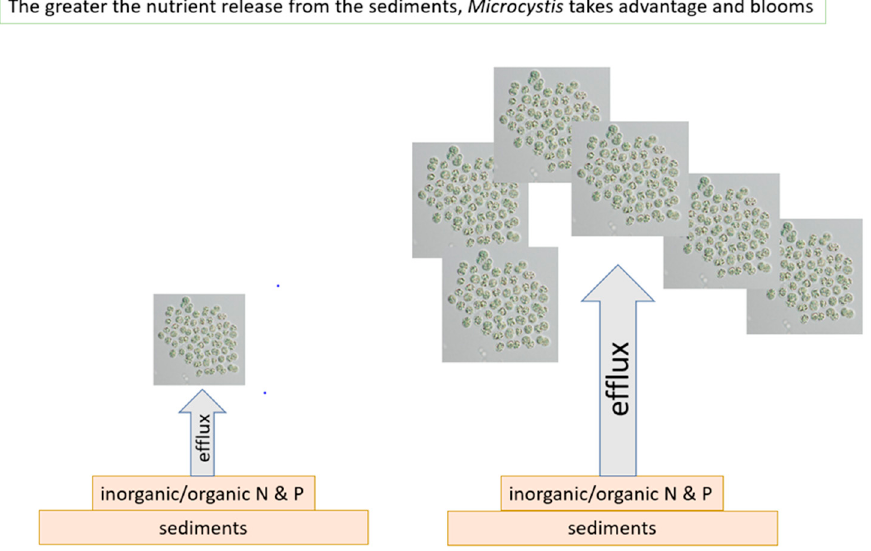
Figure 10. Microcystis blooms are a function of the nutrient releases from the sediments.